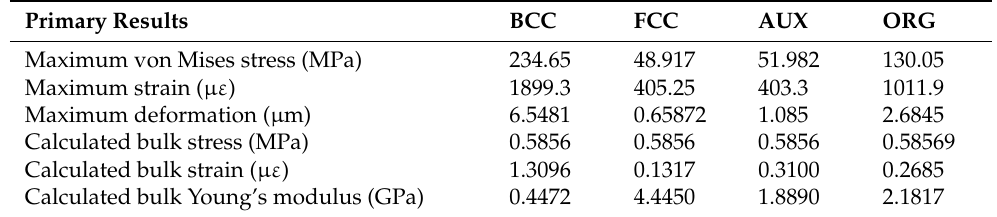
Table 6. Primary results of FEA on UCs, including calculations for bulk stress, strain, and modulus.